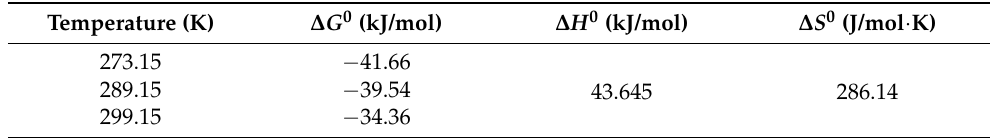
∆ G versus T of the adsorption process. Figure 5. Plot of: ( a ) ln K c versus 1/ T and ( b ) Δ G versus T of the adsorption process. Figure 5. Plot of: ( a ) lnK c versus 1/ T and ( b ) Table 1. The thermodynamic variables at different Figure 5. Plot of: ( a ) ln K c versus 1/ T and ( b ) Δ G versus T of the adsorption process.